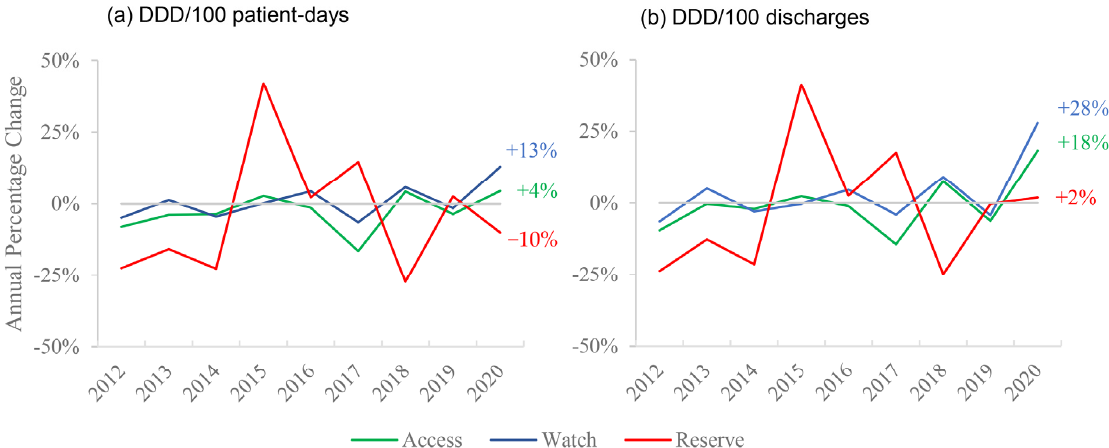
Figure 5. Annual percentage change of March–May consumption of different AWaRe groups: ( a ) analyzed by DDD/100 patient-days; ( b ) analyzed by DDD/100 discharges.